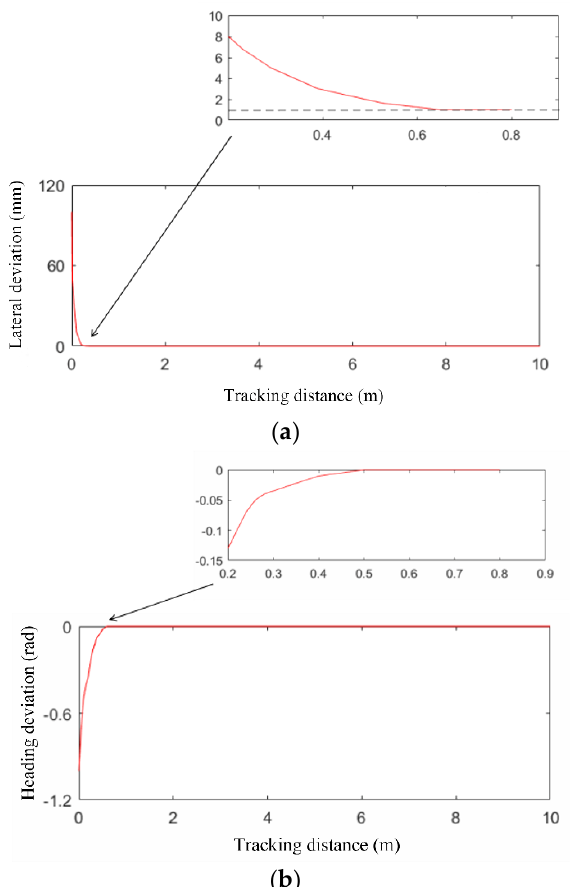
Figure 8. Path tracking error simulation results . ( a ) Lateral deviation; ( b ) heading deviation.